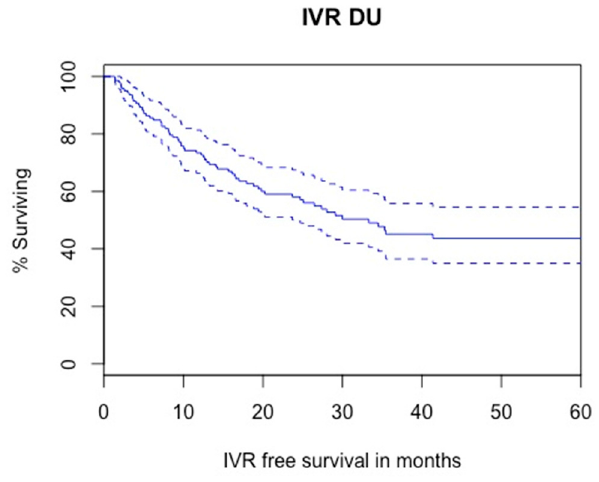
Figure 4. Kaplan–Meier modelling of intra vesical recurrence (5-year IV free survival: 43.6%, lower—upper 95% CI 0.349–0.545). Table 5. Cox regression for factors associated with